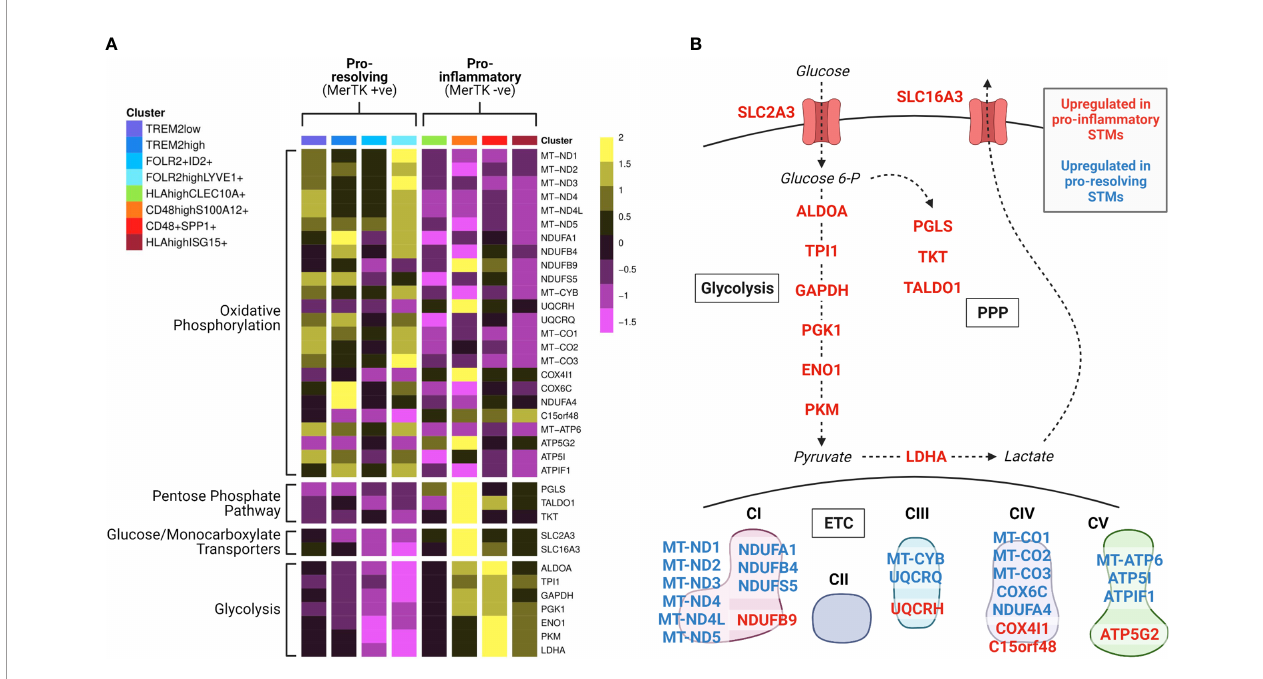
FIGURE 2 | Synovial tissue macrophage subpopulations display distinct metabolic gene expression signatures. Data from Alivernini et al. (39). (A) Heatmap of synovial tissue macrophage single cell RNA sequencing data displaying differential expression of metabolism-associated genes across macrophage subpopulations (clusters). Detailed information on the characterisation and function of different clusters and their contribution to different disease outcome groups can be found in Alivernini et al. (39). (B) Pathway schematic of the data from (A) . Genes upregulated in at least one cluster of pro-in fl ammatory macrophages are displayed in red, and genes upregulated in at least one cluster of pro-resolving macrophages are displayed in blue. STM, synovial tissue macrophage; PPP, pentose phosphate pathway; ETC, electron transport